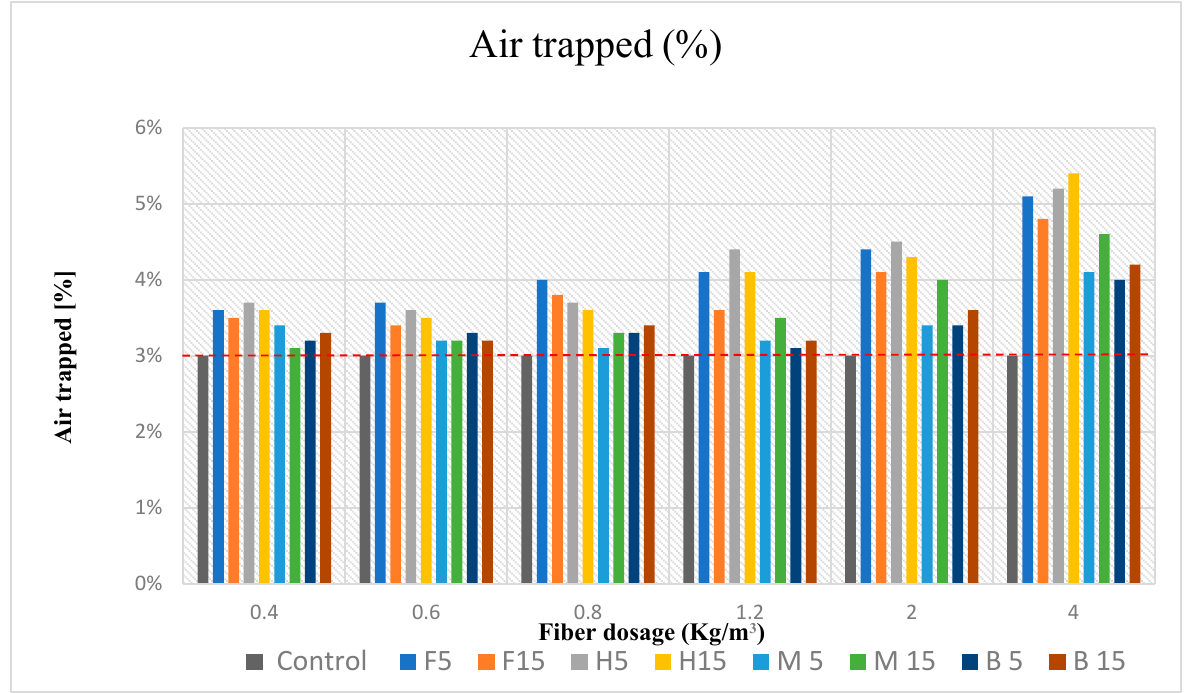
Figure 6. Entrapped air for every dosage of formulations for soft fibers and rigid fibers. The sample control entrapped air is indicated by a dashed red line. Table 8. Air trapped (%) mean value measured on three specimens for each mortar mix. CS: Control sample—Air trapped range respect CS; Air trapped CS: 3%.